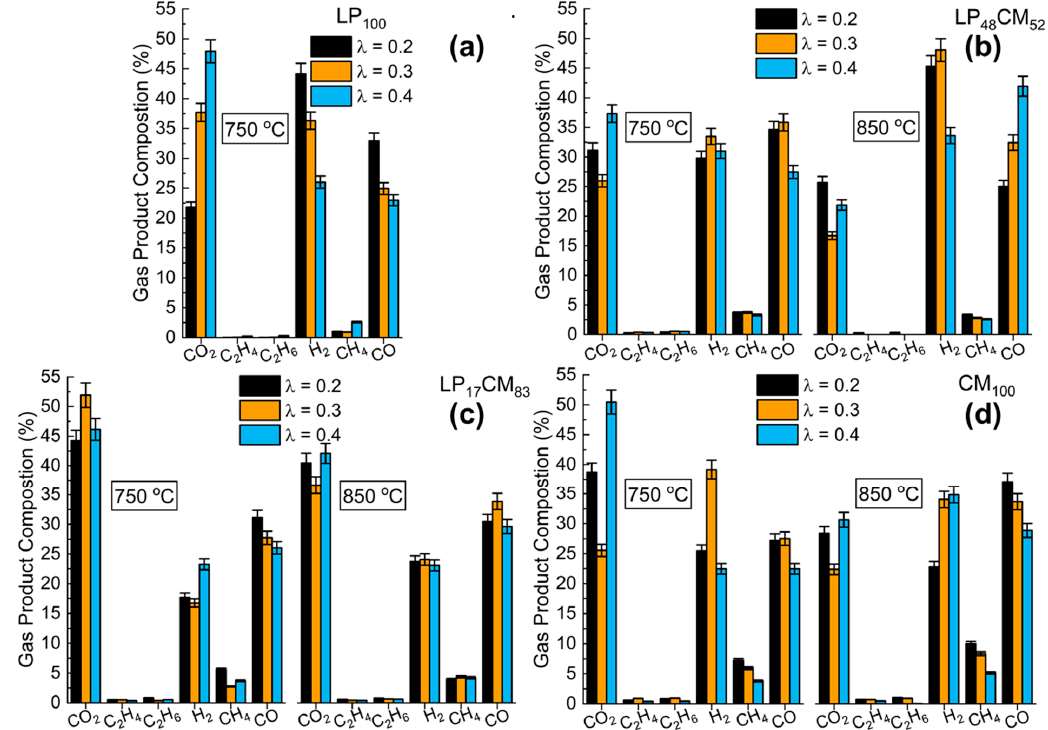
Figure 3. Gas phase product composition of: ( a ) LP 100 , ( b ) LP 48 CM 52 , ( c ) LP 17 CM 83 and ( d ) CM 100 at two different gasification temperature parameters, 750 and 850 ° C. Air content in the flux is indicated by λ .